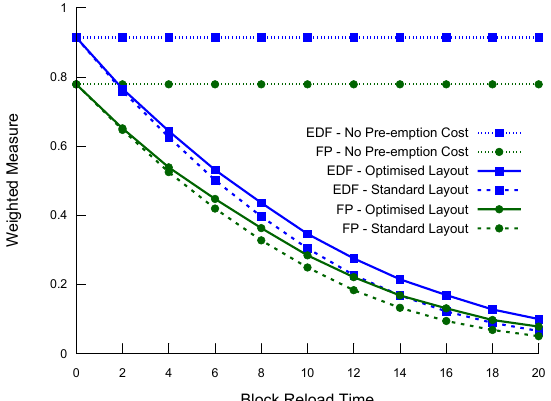
Figure 13 Weighted measure for varying the block reload time from 0 to 20 µ s in steps of 2.